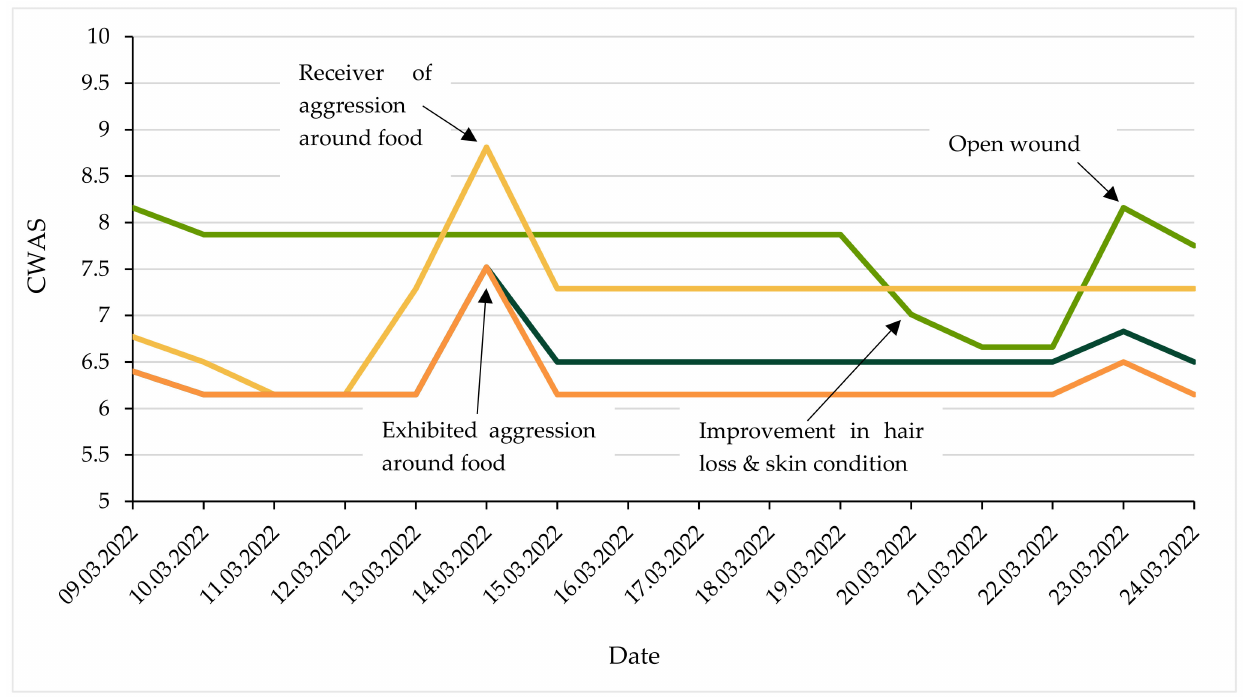
Figure 7. Cumulative welfare assessment scores (CWAS) for the four C. obscurus for the dates 9 March to 24 March 2022. Changes in CWAS indicate a likely reduction or improvement in welfare and have been highlighted alongside specific incidences that occurred on the day. Please note, the y-axis was adjusted from a minimum of 0 and maximum of 200 to emphasise the changes in CWAS which highlight discrete events that impact